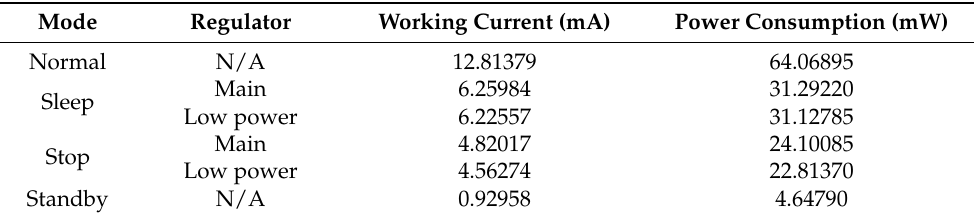
Table 2. Working current of the core board in different power modes.